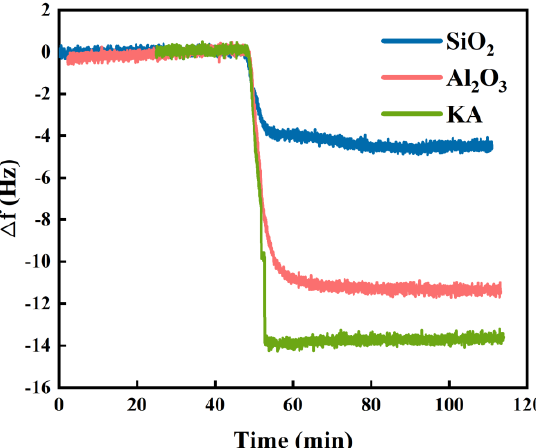
Figure 9. Frequency variation of adsorption of PEO by kaolinite, alumina, and silicon oxide chips.